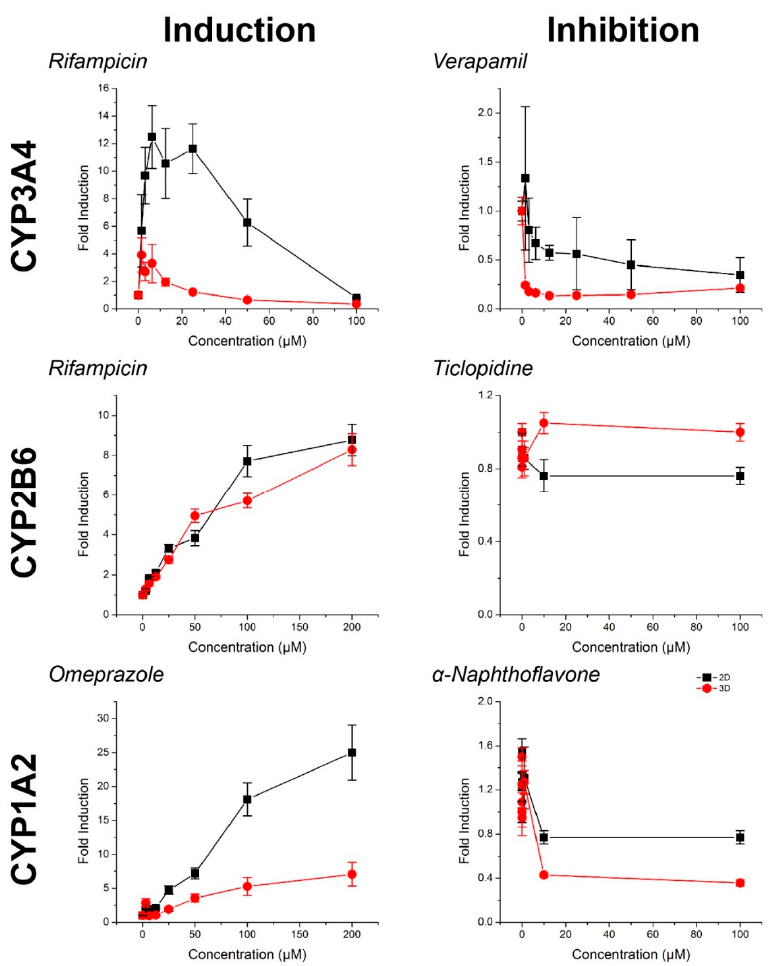
Figure 4. CYP450 fold induction and inhibition in primary human hepatocytes in response to known inducers and inhibitors of CYP3A4, CYP2B6, and CYP1A2, normalized to control. Higher or comparable CYP450 fold induction was observed in 2D compared to 3D. Aside from ticlopidine, where there was no significant inhibition, greater CYP450 fold inhibition was observed in 3D than in 2D. Error bars represent standard error.